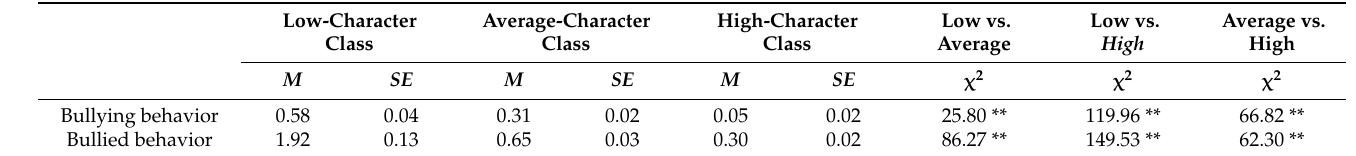
Table 2. The association of latent character classes with children’s bullying and bullied